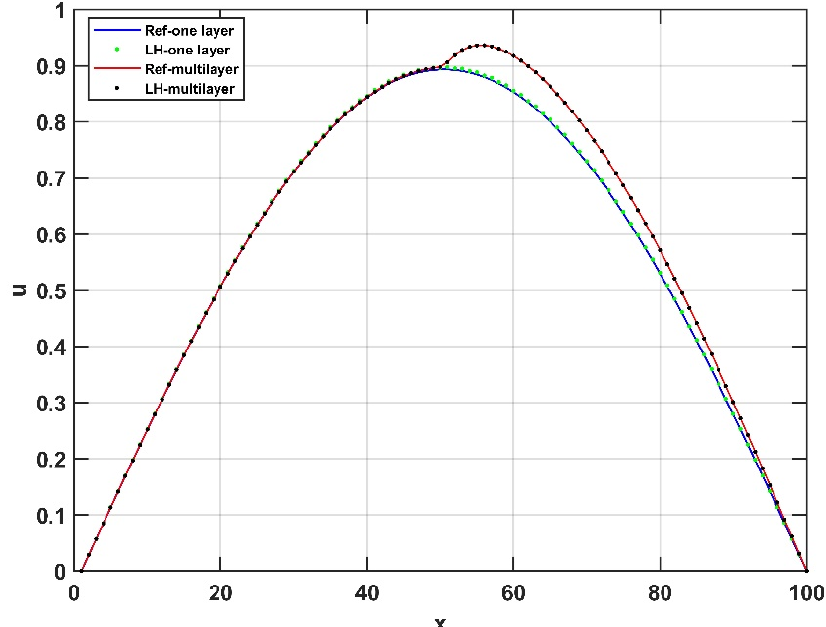
Figure 11. The temperature as a function of the cell index in the x direction at the middle row ( z ≈ 0.5 ) in the case of the reference solution (Ref) and the leapfrog-hopscotch (LH) method for ∆ t = 400 in the case of the one-layer wall and the insulated wall using an equidistant grid.